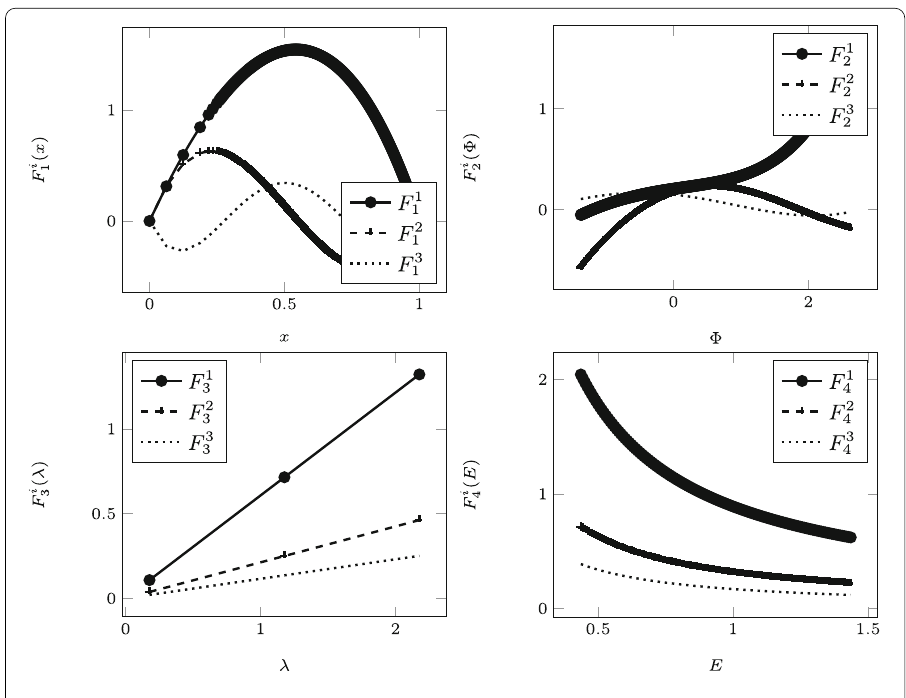
Fig. 8 1D truss: first three PGD modes of the refined PGD solution at the first design point approximation ξ = 10 μ h 0 with